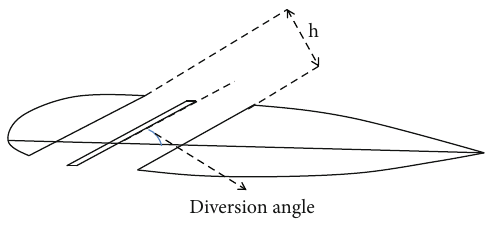
Figure 10: Diagram of diversion angle2.